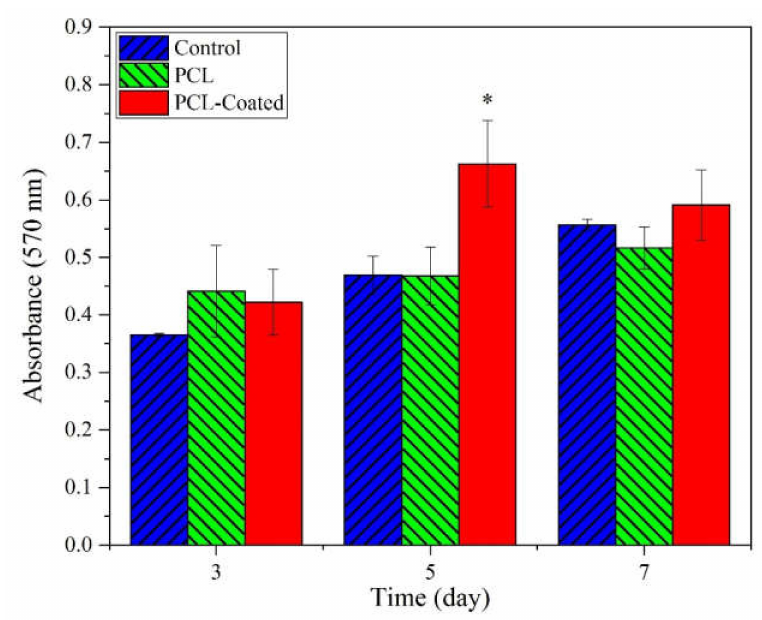
Figure 10. Evaluating the viability of HDF cells on samples using MTT assay at di ff erent times (3, 5, 7 days) for pristine PCL fibrous mats and collagen / chitosan coated samples. Medium without sca ff old was considered as the control. (One-way ANOVA analysis indicated a statistically significant di ff erence between coated and uncoated specimens at day 5, * p < 0.05, n =